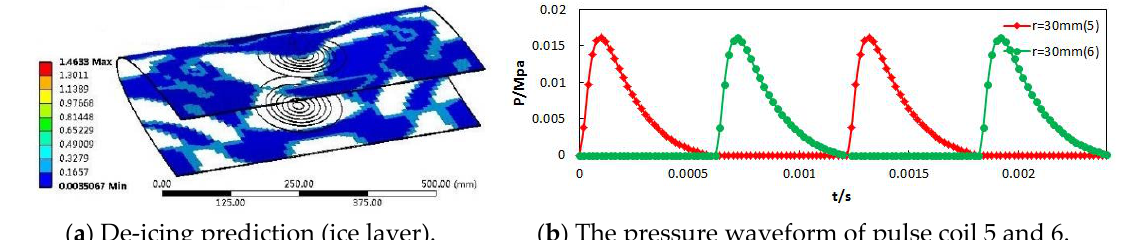
Figure 20. De-icing results of pulse coil 6 starting 600 μs later than coil 5.